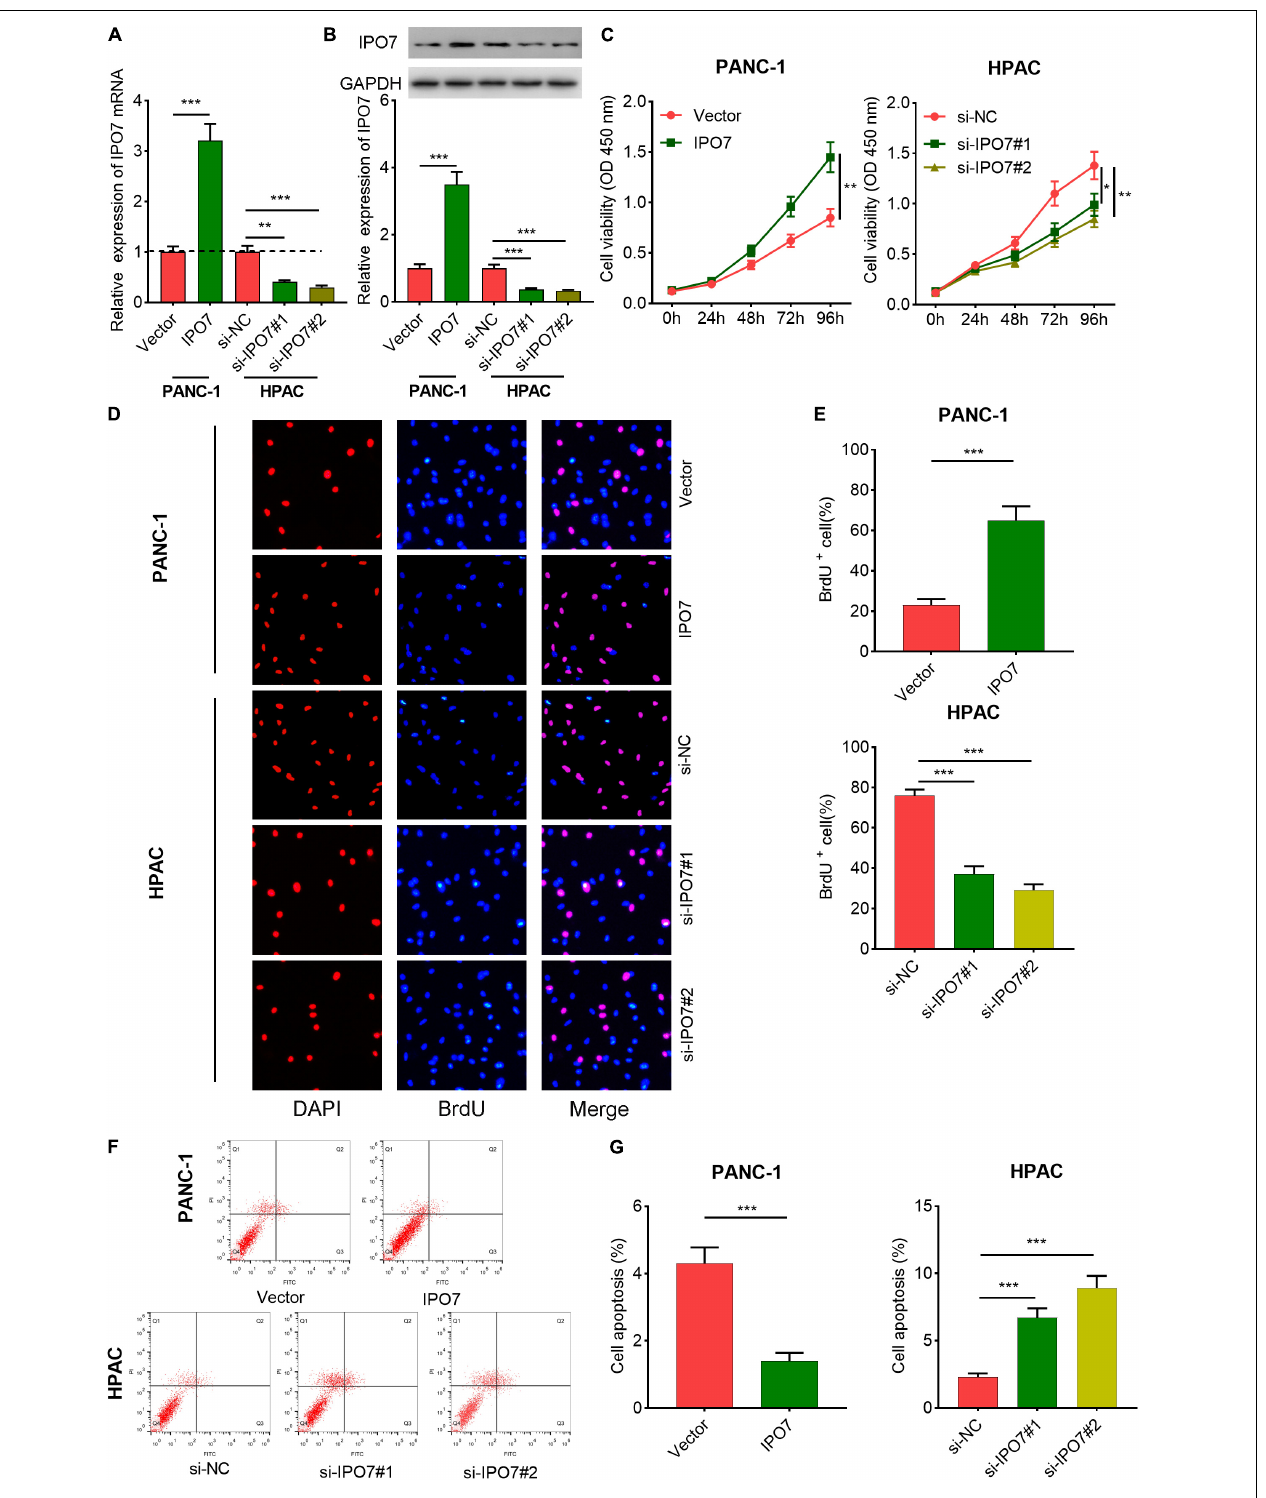
FIGURE 3 | Importin 7 (IPO7) regulates pancreatic cancer cell proliferation and inhibits cell apoptosis. (A,B) qPCR and Western blot indicated that a cell model with overexpression of IPO7 and a cell model with IPO7 depletion were successfully constructed. (C–E) Cell Counting Kit-8 (CCK-8) and 5-bromo-2 (cid:48) -deoxyuridine (BrdU) assays were used to assess the proliferation of pancreatic cancer cells with IPO7 overexpression or knockdown. (F,G) Flow cytometry was performed to detect the apoptosis of pancreatic cancer cells with IPO7 overexpression or knockdown. * p < 0.01, ** p < 0.01, *** p < 0.001.